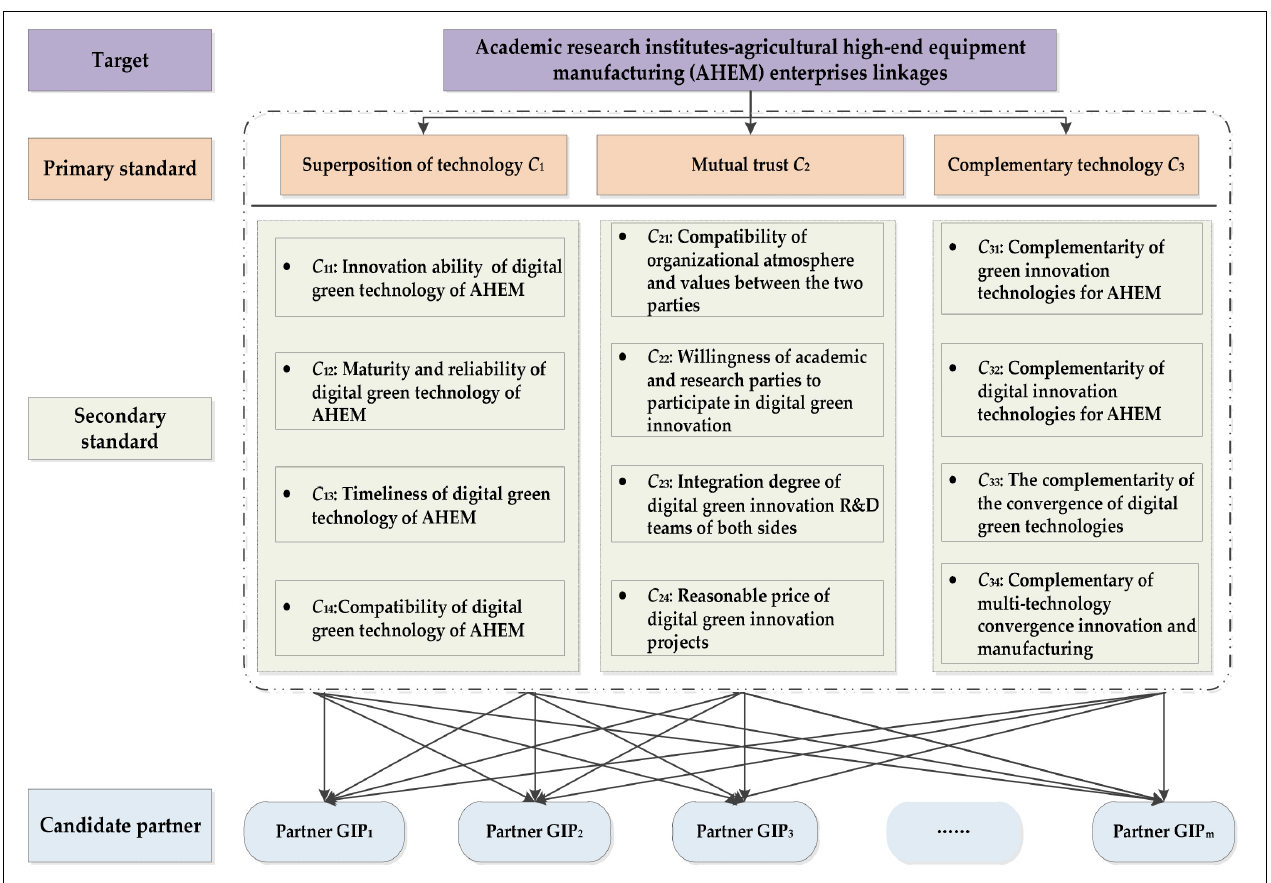
FIGURE 2 | The evaluation system of academic research institutions selection of DGI based on niche